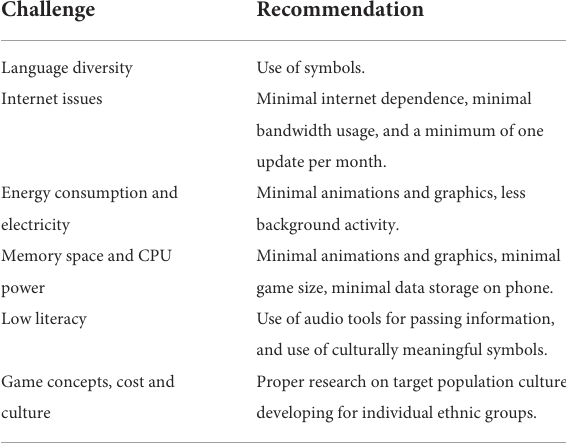
TABLE 2 Summary of recommendations for serious mobile game design for rural African areas